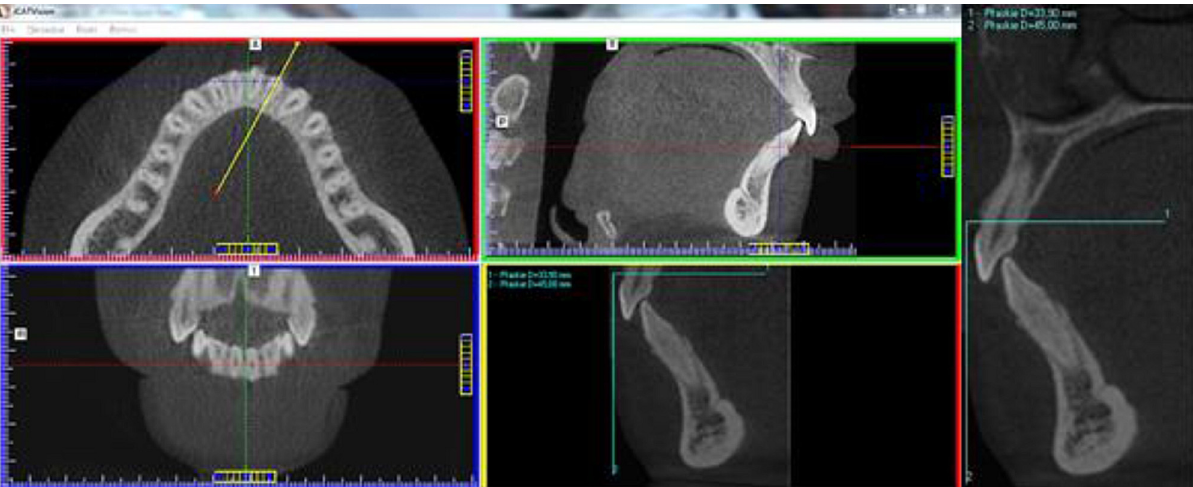
Figure 1: A drawing of the line determining the plane of a cross - sectional slice in the area of the examined tooth as well as a drawing of the calibration lines.